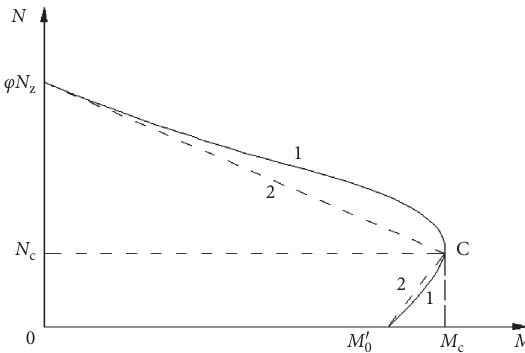
Figure 23: Simplified model of N-M resistance correlation curves of columns.